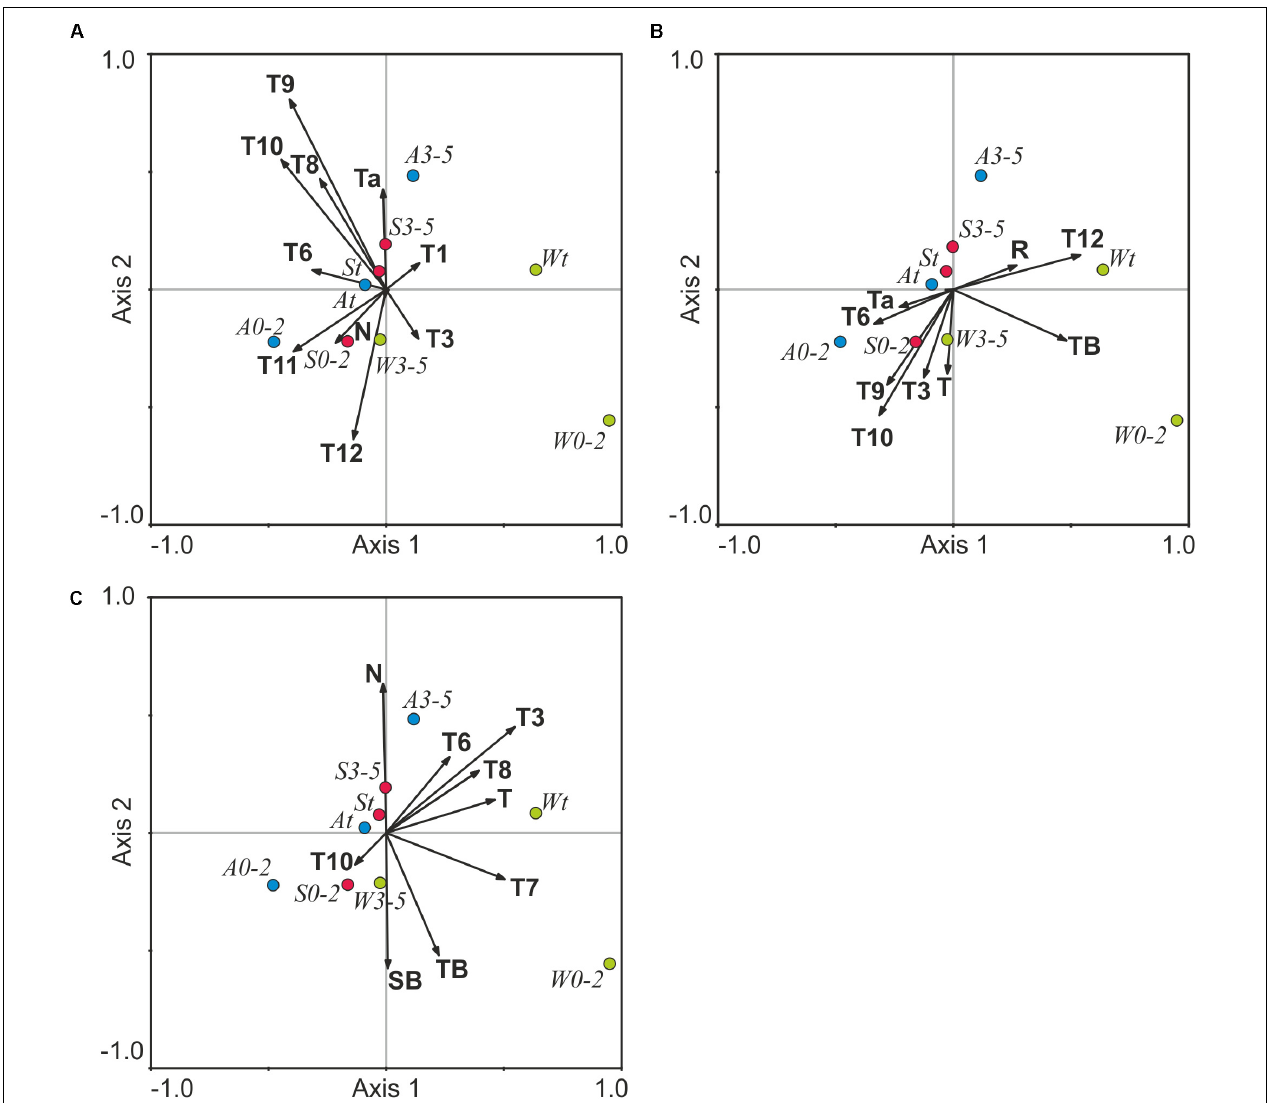
FIGURE 4 | Canonical Correspondence Analysis showing red king crab characteristics in relation to environmental variables in Dalnezelenetskaya Bay at lag 0 (A) , lag 1 (B) , and lag 2 (C) . For abbreviations see Figures 2 , 3